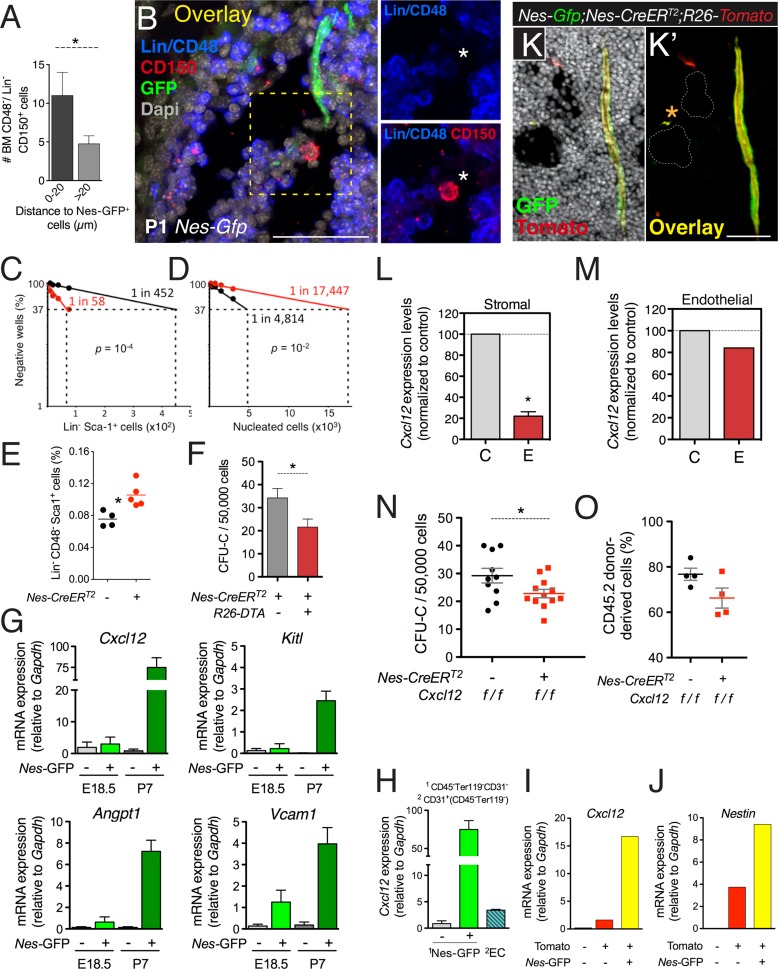
CXCL12 produced by nestin+ MSCs contributes to the establishment of the HSC niche in the bone marrow.(A and B) HSCs are localized near Nes-GFP+ cells in neonatal bone marrow. Neonatal femoral sections from Nes-Gfp mice were immunostained with antibodies for mature hematopoietic lineages, CD48 (blue) and CD150 (red). (A) Quantification of the distance of Lin− CD48− CD150+ HSC-enriched cells from Nes-GFP+ cells (mean ± SEM, n = 41). (B) Representative image of a putative HSC (asterisk) near a Nes-GFP+ cell. (C–F) Depletion of nestin+ cells compromises developmental HSC migration to bone marrow. (C and D) Long-term culture-initiating cell (LTCIC) assay from nestin-depleted fetal liver and bone-marrow cells. Nes-CreERT2;iDTR (red dots) and control iDTR (black dots) mice were exposed to tamoxifen at E14.5 and diphtheria toxin at E15.5, and liver cells (C) and bone marrow cells (D) were isolated at E17.5 (n = 5-6). The percentage of culture dishes that failed to generate hematopoietic colony-forming units in culture (CFU-C) is plotted against five serial dilutions of (C) fetal liver Lin− Sca-1+ cells and (D) nucleated bone marrow cells. HSC frequencies and p values are indicated (Pearson’s chi-squared test). (E) Frequency of Lin− Sca-1+ E17.5 liver cells in mice in (C). (F) Bone marrow CFU-C content in 1-week old Nes-CreERT2;R26-DTA and control littermates treated with tamoxifen at birth (n = 3–7). (G) Expression of core HSC maintenance genes increases in perinatal Nes-GFP+ BMSCs. qPCR analysis of Cxcl12, stem cell factor/kit ligand (Kitl), angiopoietin-1 (Angpt1), and vascular cell adhesion molecule-1 (Vcam1) mRNA in CD45- CD31- Ter119- GFP+/− cells isolated from E18.5 and P7 Nes-Gfp bone marrow. (H) Relative Cxcl12 mRNA expression levels in endothelial cells and Nes-GFP+/- BMSCs isolated from 1-week old mice (qPCR; n = 2). (I and J) Relative enrichment of Cxcl12 (I) and Nestin (J) mRNA expression in populations sorted from the bone marrow of P7 Nes-Gfp;Wnt1-Cre2;R26-Tomato compound transgenic mice. (K) Representative confocal image of a bone marrow section from a 1-week old (P7) Nes-Gfp;Nes-CreERT2;R26-Tomato mouse treated with tamoxifen at birth. Both sinusoidal (asterisk) and arteriolar GFP+ cells express the Nes-CreERT2-derived Tomato (red) reporter (yellow in overlaid picture, K′). (L and M) Efficiency of perinatal Cxcl12 excision by the Nes-CreERT2 driver in CD45-Ter119−CD31- cells (L) and endothelial (M) cells isolated from P7 bone marrow; qPCR in CD45-Ter119−CD31- cells isolated from Cxcl12f/f;Nes-CreERT2 (E) and control (C) littermates treated with tamoxifen at birth (n = 2-3). (N and O) Bone marrow CFU-C (N) and long-term HSC (O) content in P7 Cxcl12f/f;Nes-CreERT2 and control littermates treated with tamoxifen at birth. (O) Lethally-irradiated mice (CD45.1) were transplanted with 1 ×106 bone marrow cells from P7 Cxcl12f/f;Nes-CreER or Cxcl12f/f mice (CD45.2), together with 1 × 106 recipient bone marrow cells (CD45.1). Peripheral donor-derived blood chimerism after 16 weeks is shown (n = 4 per group). (E, L) Each dot represents an individual mouse. (F, H–J) Mean ± SD. *p < 0.05, unpaired two-tailed t test.